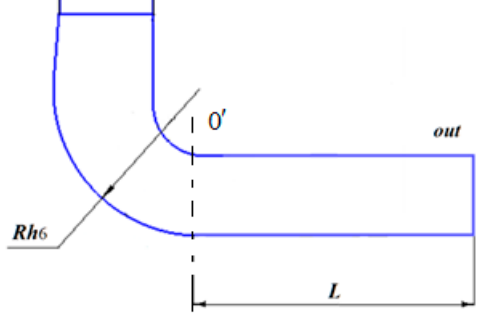
Figure 6. Scheme of the outlet section of the RCh for CFD calculation.